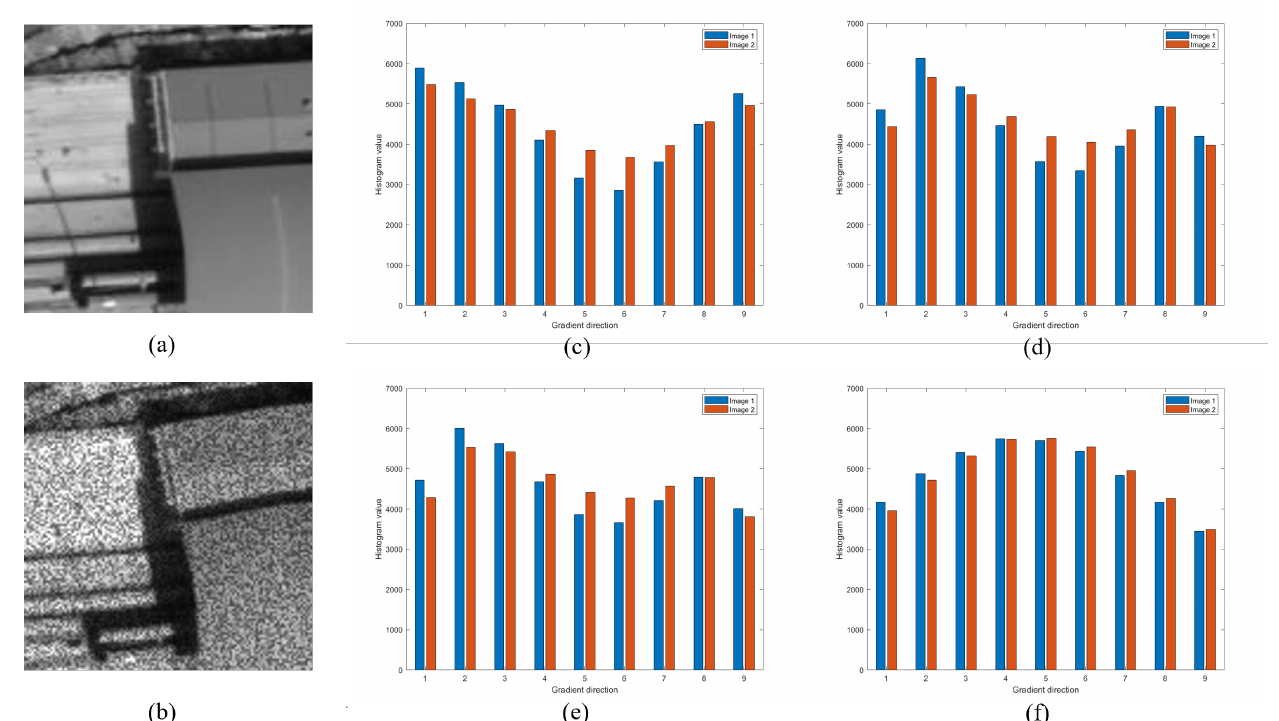
Figure 6. Comparison of Z-direction convolution of HOPES descriptors: ( a ) original image; ( b ) distorted and noise contaminated images; ( c ) HOPES descriptors without the Z-direction convolu- tion; ( d ) HOPES descriptors with [ 1,2,1 ] T Z-direction convolution; ( e ) HOPES descriptors with σ = 1, size = 5 Z-direction Gauss convolution. ( f ) HOPES descriptors with σ = 3 , size = 11 Z-direction Gauss convolution.